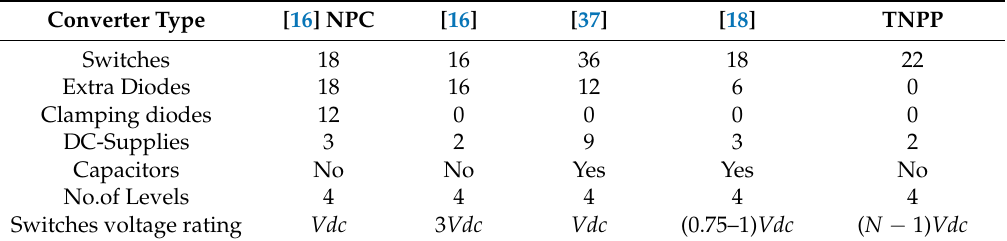
Table 5. Comparison between the proposed T-NPP and other topologies.